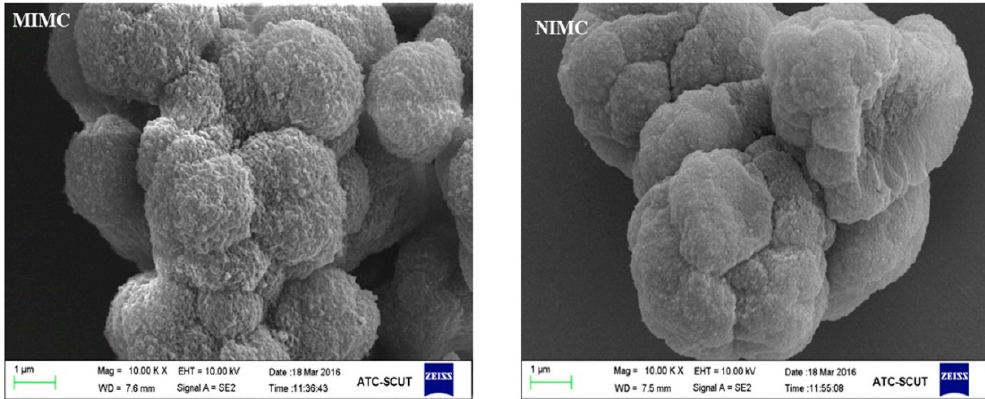
Figure 3. Scanning electron microscope images of molecularly imprinted monolithic column (MIMC) and non-molecularly imprinted monolithic column (NIMC).